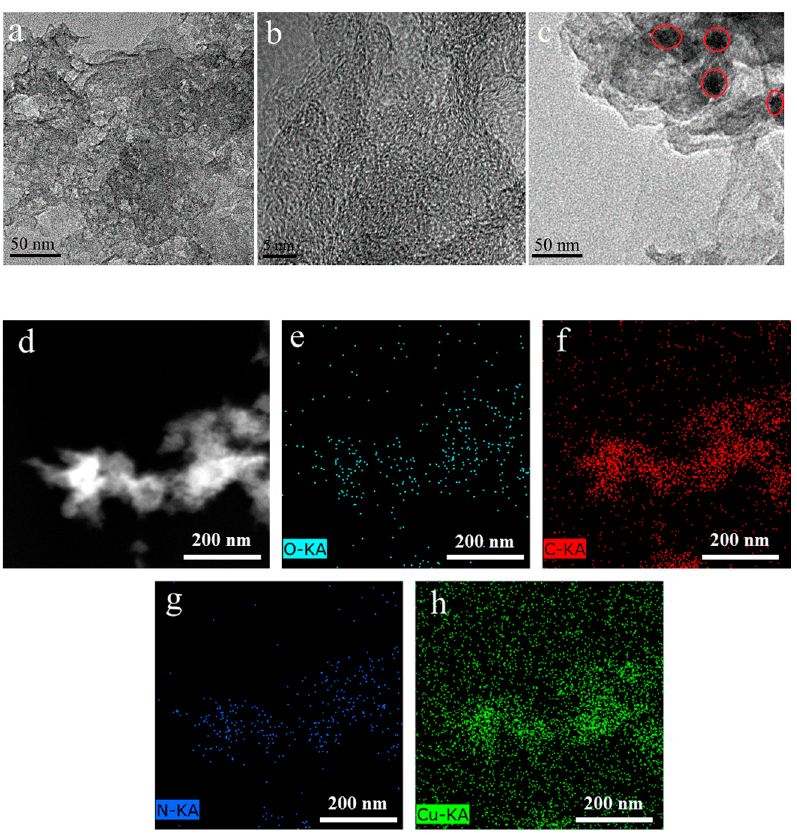
Figure 1. TEM images of ( a , b ) 3%Cu/N-rGO and ( c ) 100%Cu/N-rGO. ( d ) High angular annular dark field image and elemental mapping images of ( e ) oxygen, ( f ) carbon, ( g ) nitrogen, and ( h ) copper elements of 3%Cu/N-rGO.